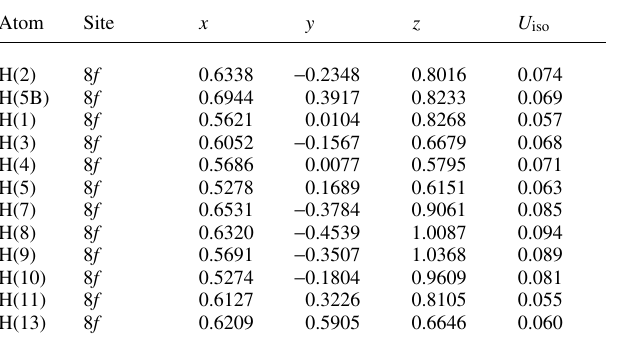
Table 2. Atomic coordinates and displacement parameters (in Å 2 )